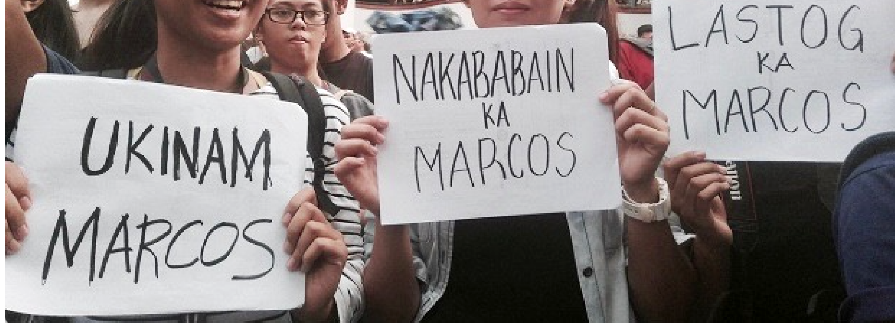
Figure 3. Monolingual protest signs. Young women express dissent by swearing at Marcos in ‘colorful’ Ilocano (‘Ukinam,